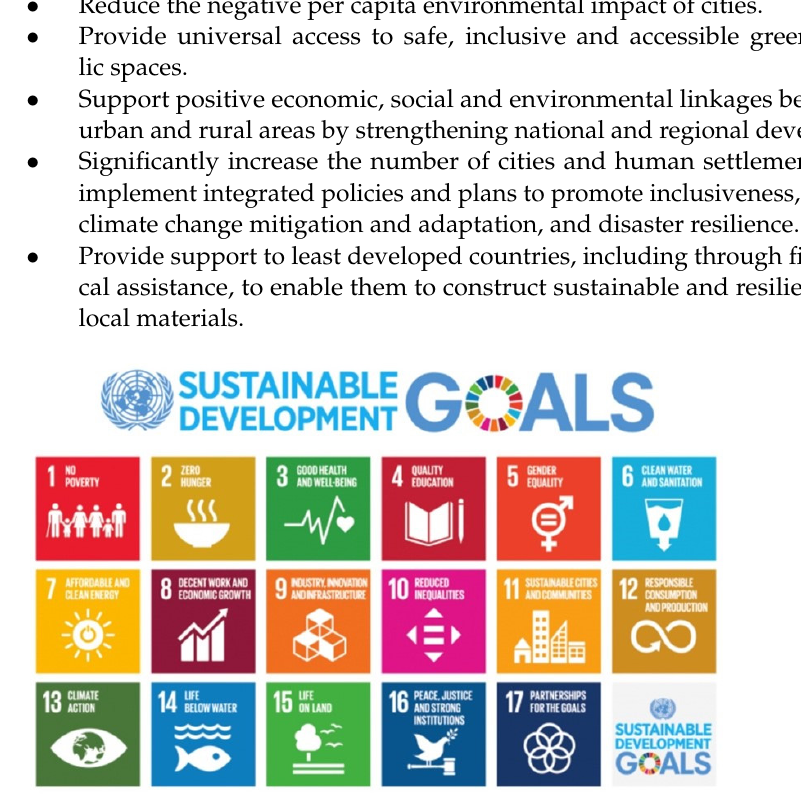
Figure 1. Sustainable Development Goals (United Nations).